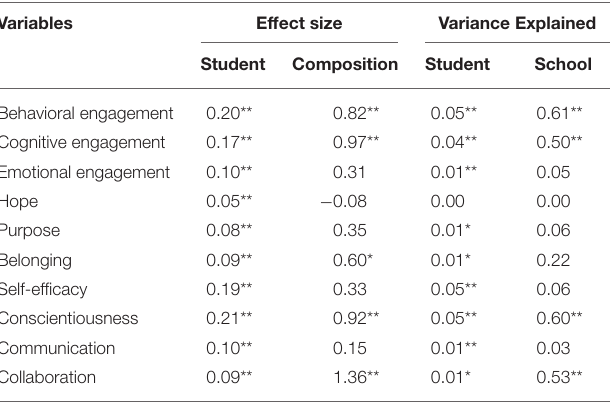
TABLE 5 | Student and peer composition effects on academic performance, controlling for student